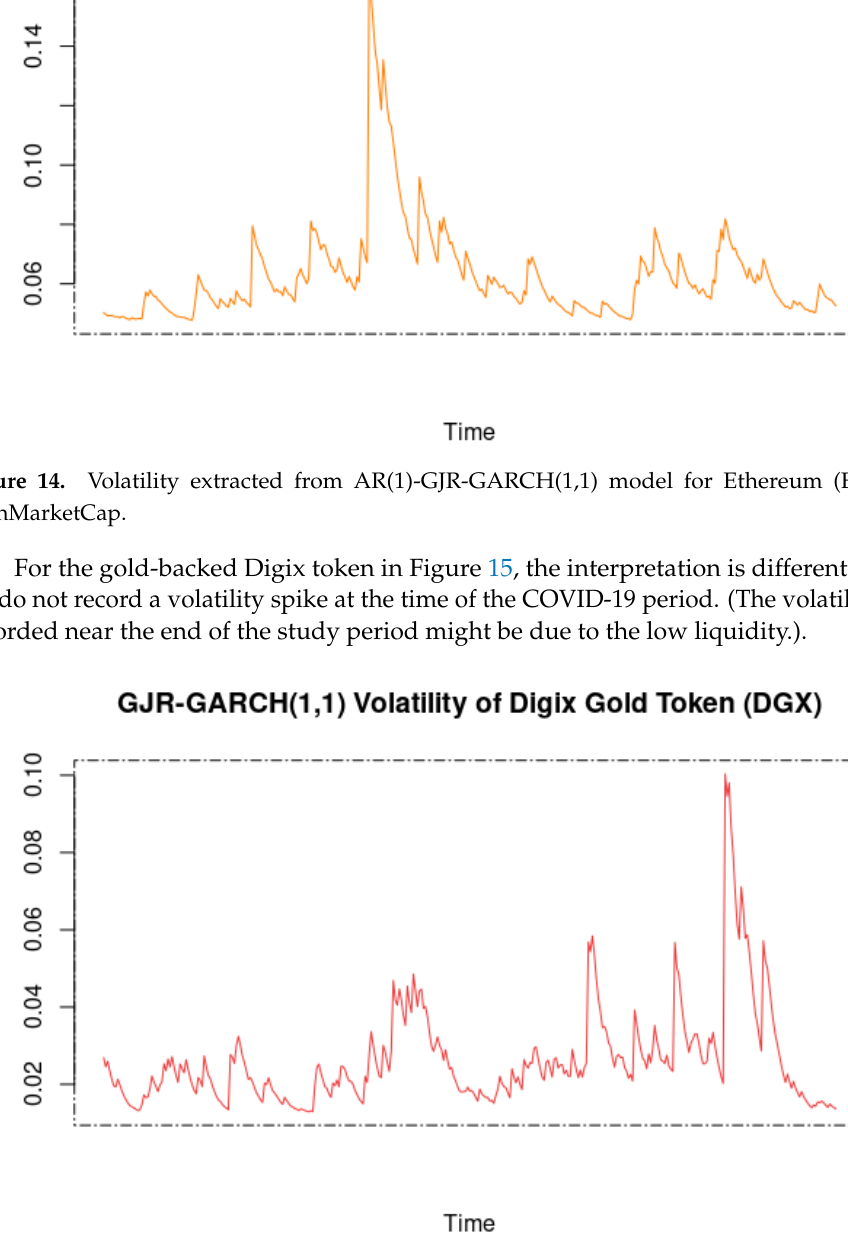
Figure 15. Volatility extracted from AR(1)-GJR-GARCH(1,1) model for Digix gold token (DGX)—